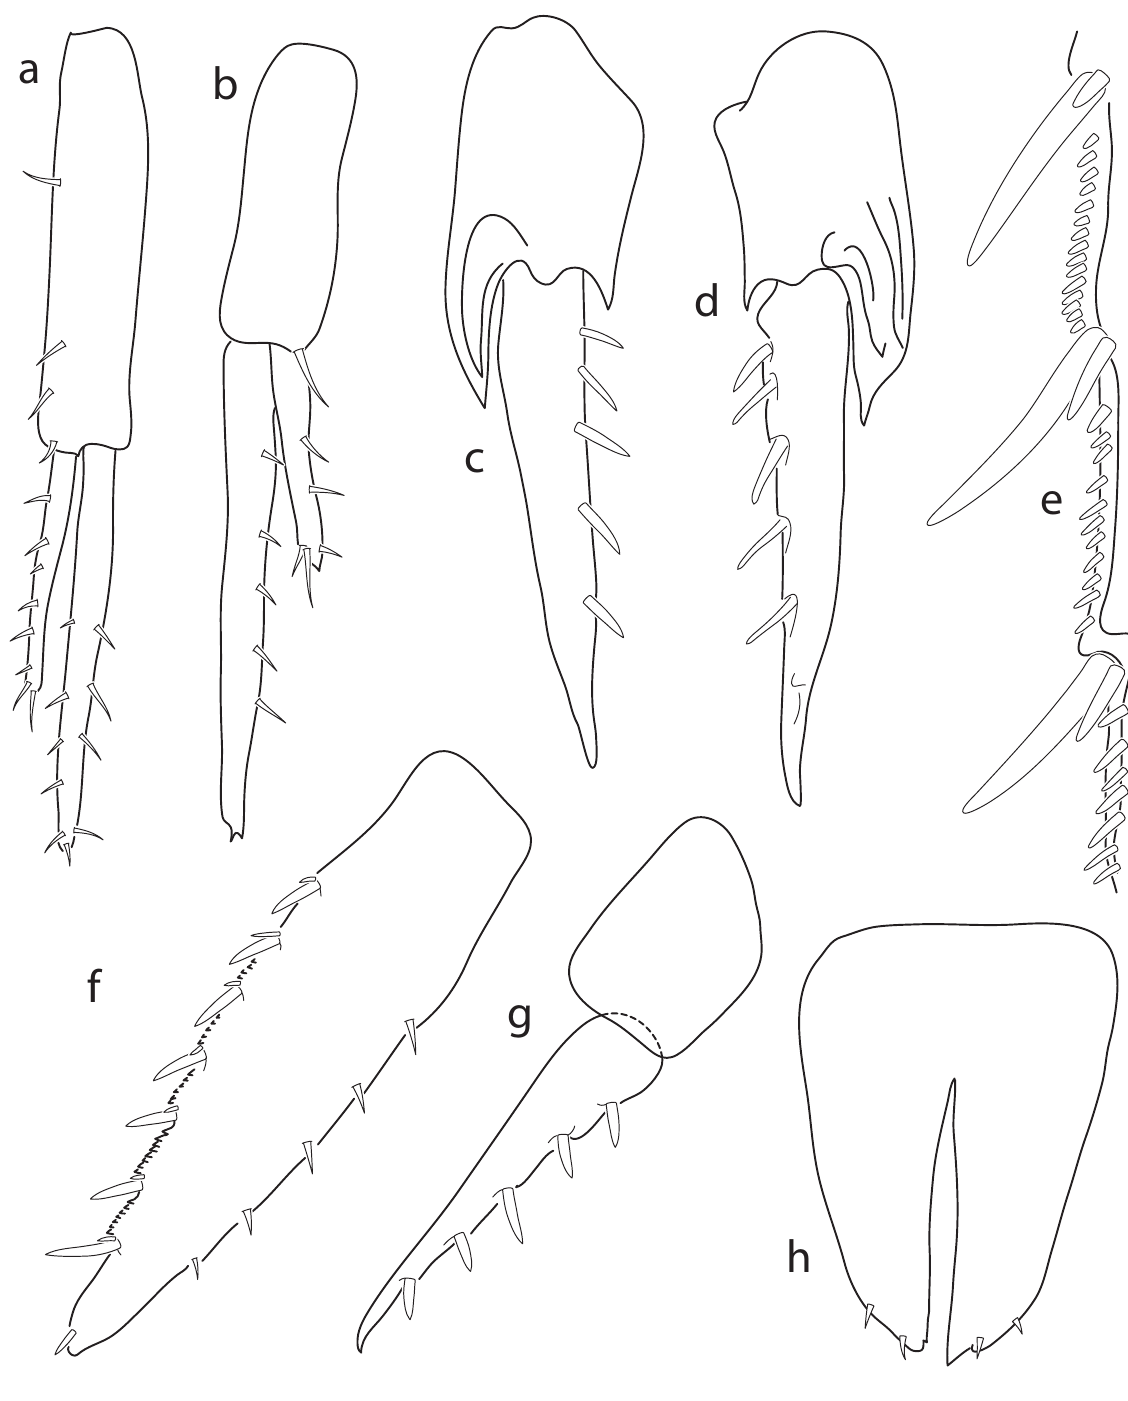
Fig. 26. Liouvillea rocagloria sp. nov., holotype, ♀, 8 mm (MVRCr 7734). a . Uropod 1. b . Uropod 2. c . Uropod 3. d . Uropod 3. e . Margin of ramus of uropod 3. f . Uropod 3 ramus. g . Uropod 3 (partially) different aspect. h . Telson. Figure not